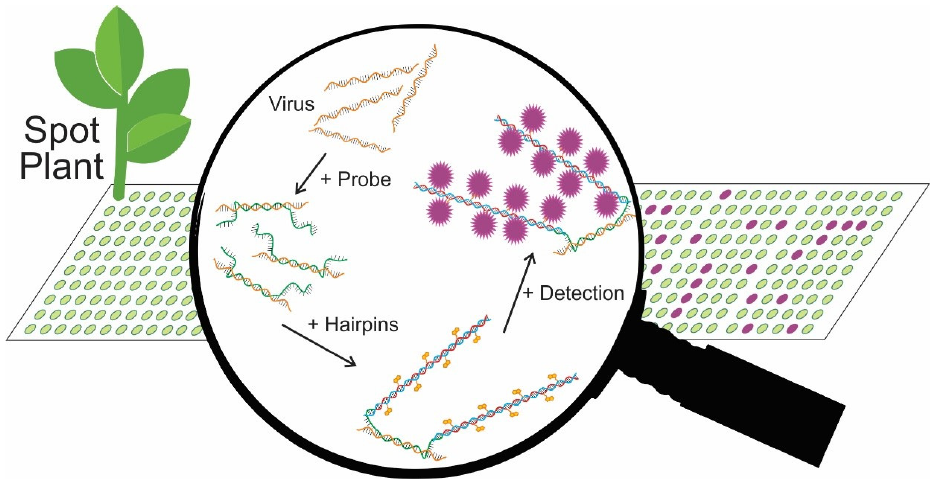
Figure 1. The tissue blot hybridization chain reaction (TB-HCR). Plants stems are cut and blotted onto the nitrocellulose membrane. Proteins, DNA, and RNA adhere to the membrane. DNA probes, designed to complement a specific virus or a group of viruses and contain flanking initiator sequences, attach to virus DNA/RNA on the membrane. The addition of metastable hairpins (H1 and H2) interact with the probe initiators, triggering a chain reaction in which H1 and H2 hairpins sequentially open to assemble into long double-stranded polymers. Either both or just one hairpin contains a reporter such as biotin, amplifying the signal-to-background ratio of the virus:probe interaction. Detection can then be visualized via the reporter on the hairpins.